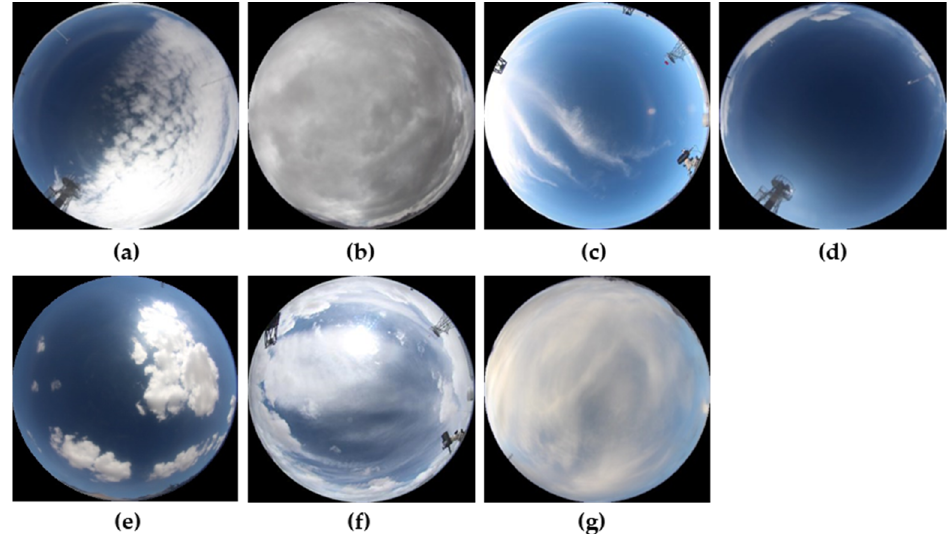
Figure 8. Example images from the ASGC dataset: ( a ) altocumulus (Ac); ( b ) cumulonimbus (Cb); ( c )